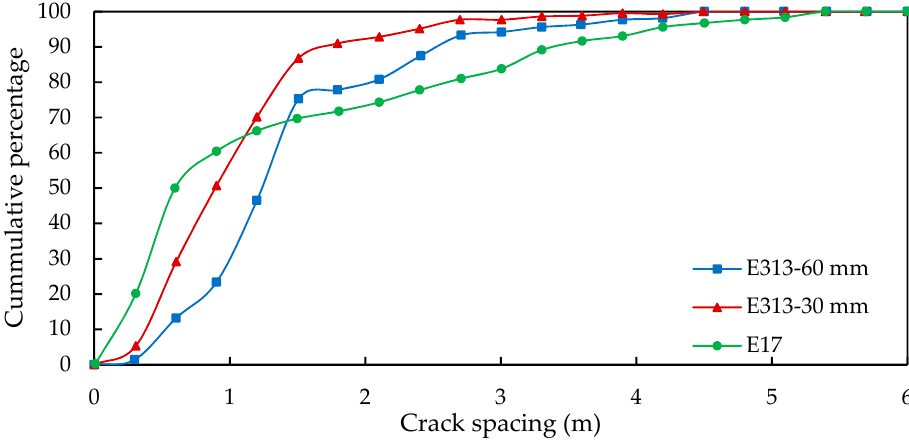
Figure 2. Comparison of cumulative crack spacing distribution.